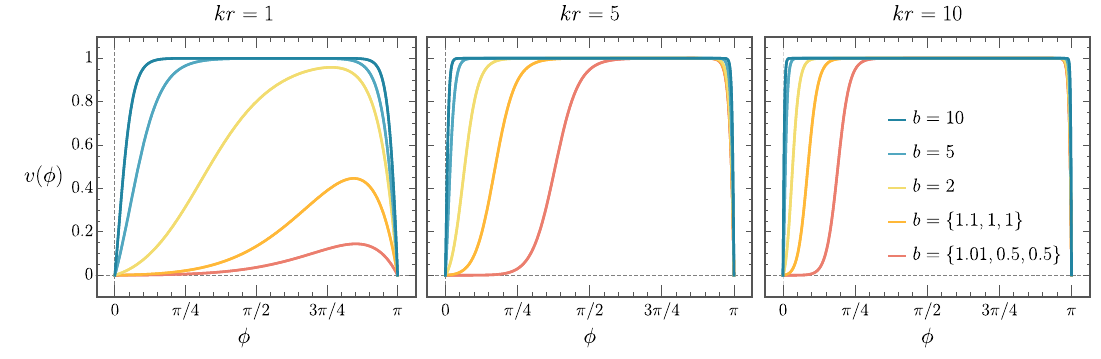
Figure 4 . Solutions for the scalar VEV v ( (cid:30) ) for di(cid:11)erent choices of kr and b > 1 =kr . In the legend, we show in brackets the values of b used for the di(cid:11)erent (cid:12)gures, from left to right, such that the constraint b > 1 =kr is